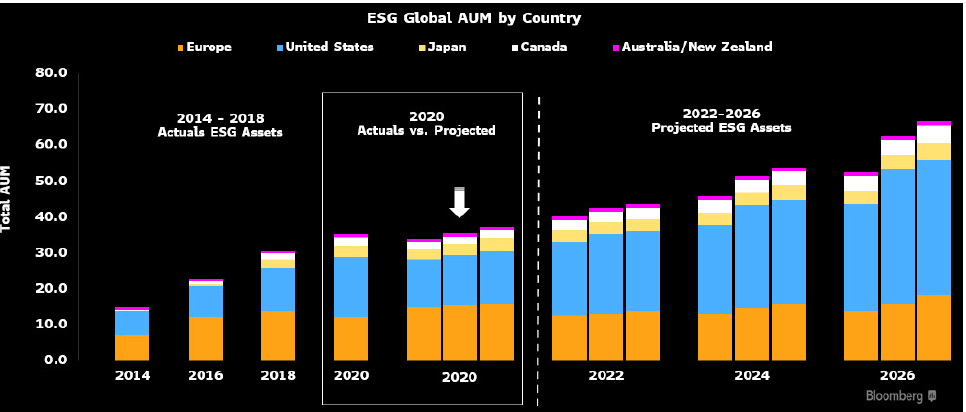
Figure A1. ESG AUM by countries Bloomberg, low, medium and high scenarios. Source: Global Sustainable Investment Alliance, Bloomberg